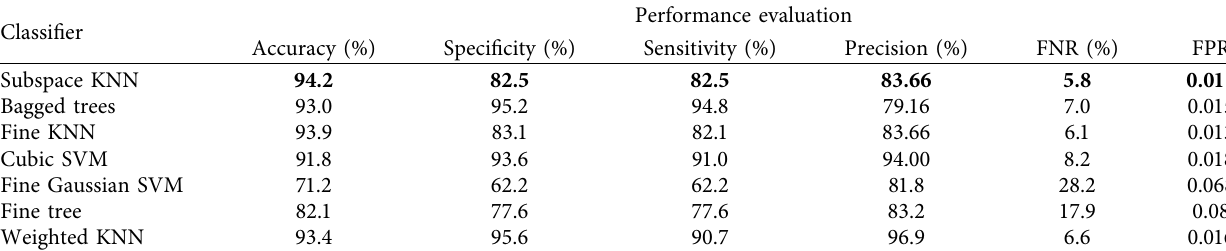
Table 7: Performance evaluation of experiment 3.